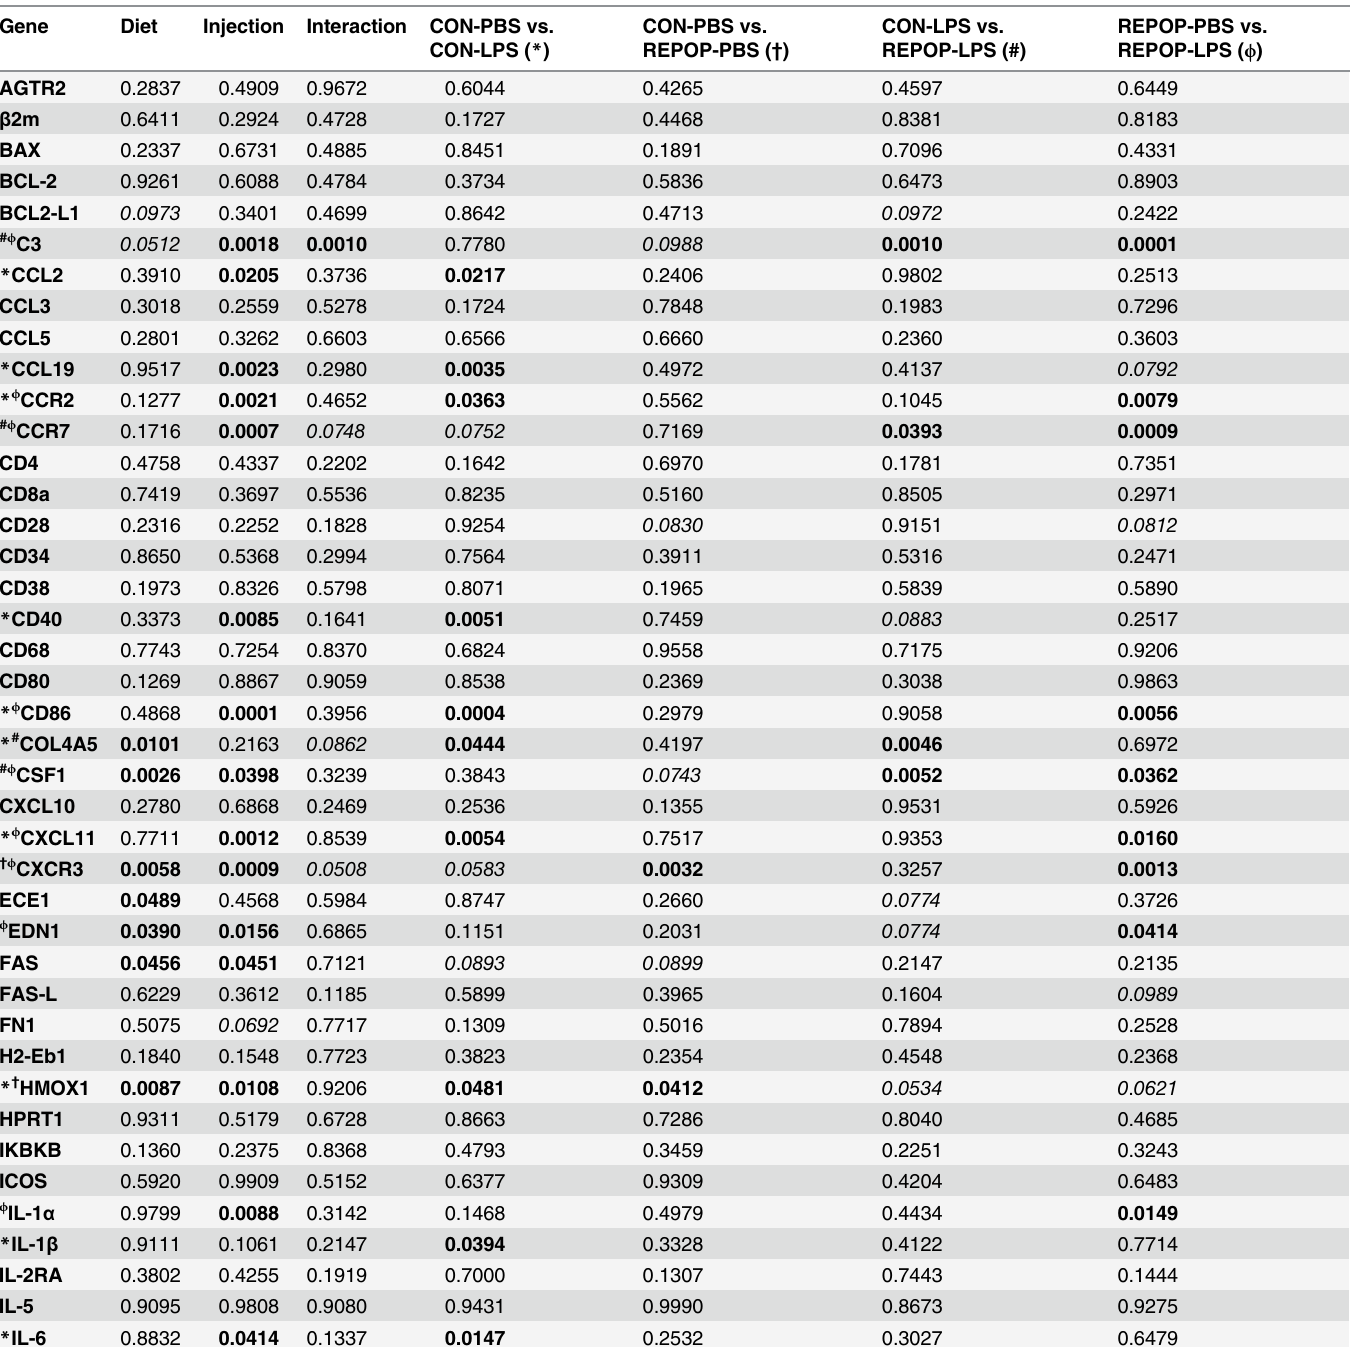
Table 1. P-values for Statistical Analysis of Inflammatory